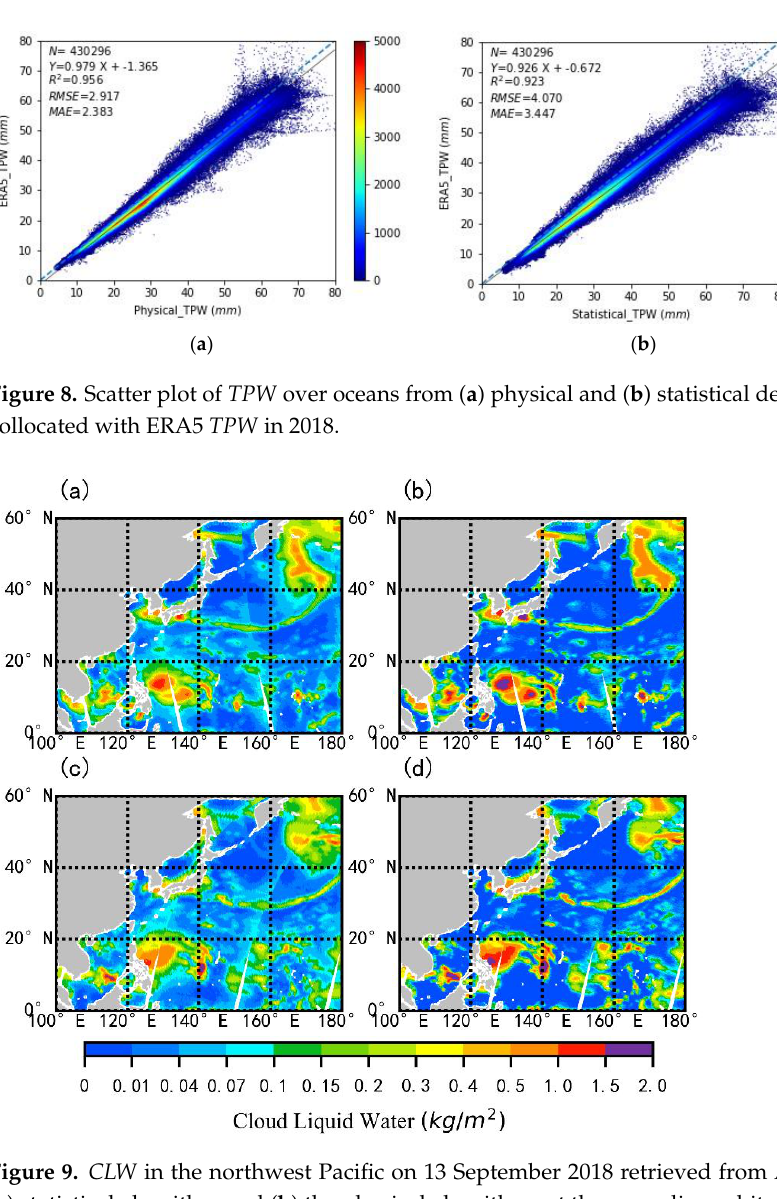
Figure 8. Scatter plot of TPW over oceans from ( a ) physical and ( b ) statistical descending orbit data collocated with ERA5 TPW in 2018.